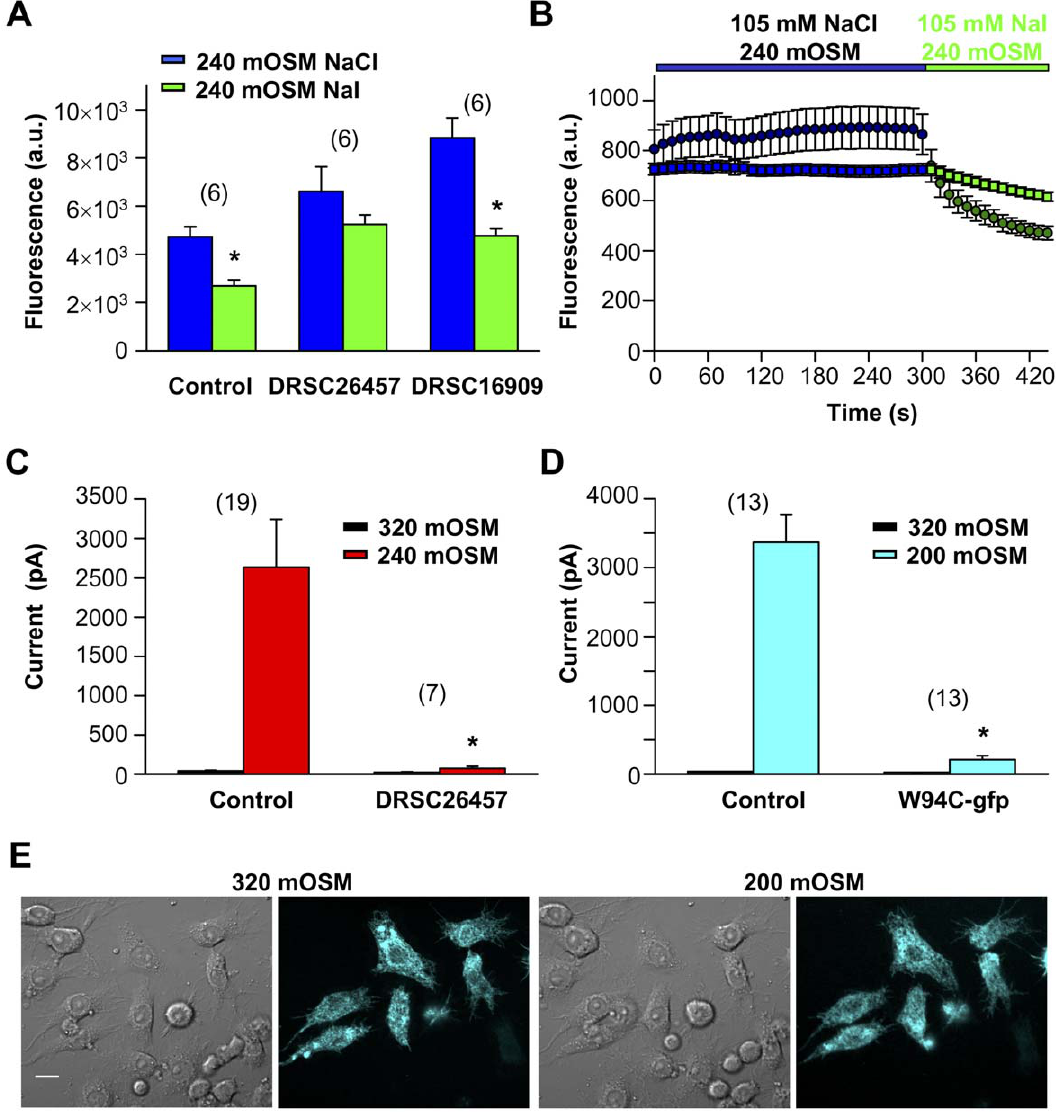
Figure 5. DRSC26457 identifies dBest1 as Cl swell . ( A & B ) RNAi efficiently targeting dBest1 prevents significant I – induced H148Q-YFP suppression following hypo-osmotic stimulation. Fluorescence is in arbitrary units (a.u.). ( A ) Plate reader assay. DRSC26457 RNAi treatment resulted in a fluorescence decrease of 6.4% 6 19. Control and DRSC16909 RNAi treatment resulted in fluorescence decreases of 40.5% 6 9.1 and 43.7% 6 6.2 respectively. * 240 mOSM NaCl and NaI fluorescence levels are significantly different (Student’s t-test, p , 0.05). ( B ) Imaging assay. The fluorescence levels of individual S2R + cells treated with control or dBest1 DRSC26457 RNAi were measured during hypo-osmotic stimulation in the sequential presence of Cl 2 and I 2 . The fluorescence of control cells decreased by 56% (n=44); in contrast, the fluorescence of dBest1 DRSC26457 RNAi treated cells was suppressed by 15% (n=174). ( C ) dBest1 DRSC26457 RNAi eliminated I Clswell in S2R + cells. Following dBest1 RNAi treatment I 320 is not significantly different from I 240 (Student’s t-test, p=0.1). * control and RNAi treated I 240 are significantly different (Student’s t-test, p=0.02). ( D ) dBest1 W94C-gfp overexpression suppresses S2R + I Clswell . * control and W94C-gfp I 200 mOSM are significantly different (Student’s t-test, p=0.02). ( E ) Confocal images of dBest1 W94C-gfp overexpression in S2R + cells. Images were obtained before (320 mOSM) and after swell (200 mOSM). Scale bar indicates 10 m m.